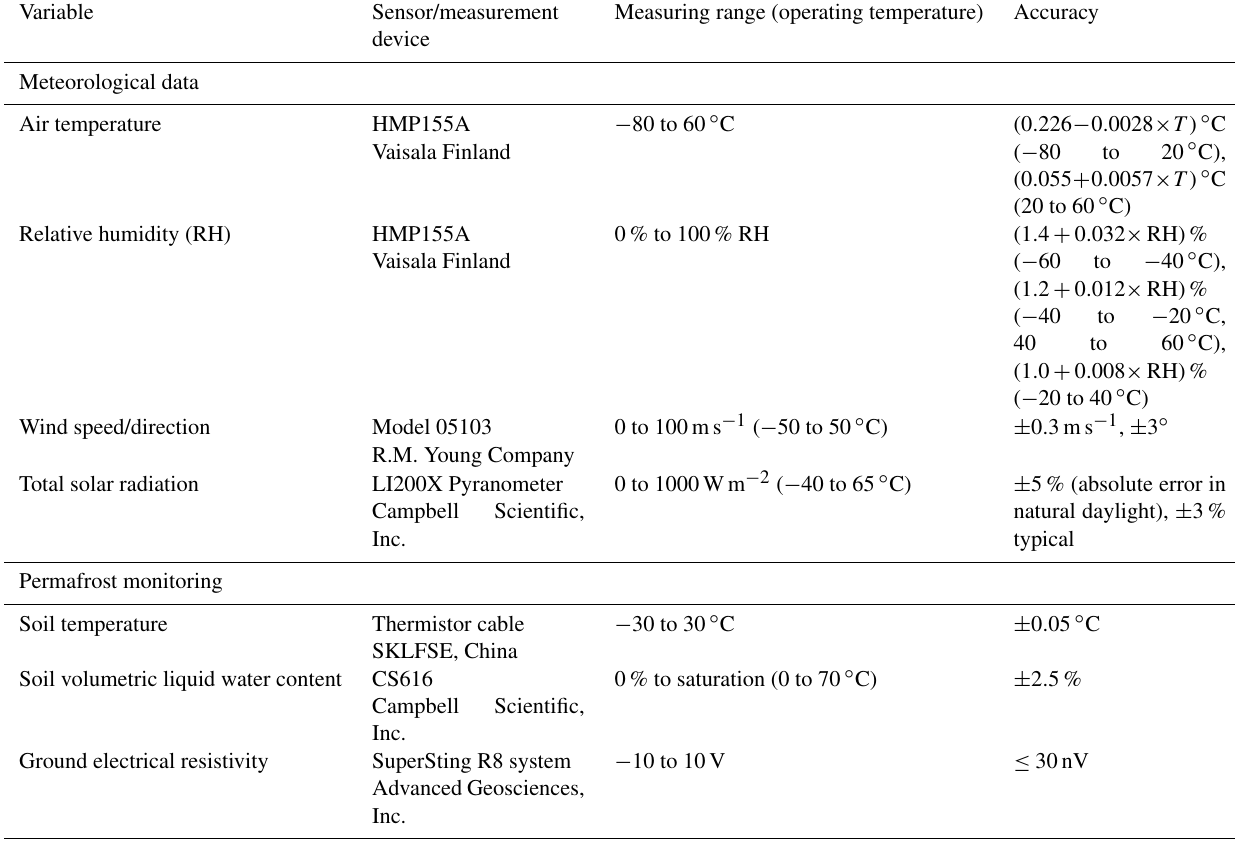
Table 2. List of sensors, measuring range and accuracy for meteorological data, ground temperature, soil water content, and ground electrical resistivity.